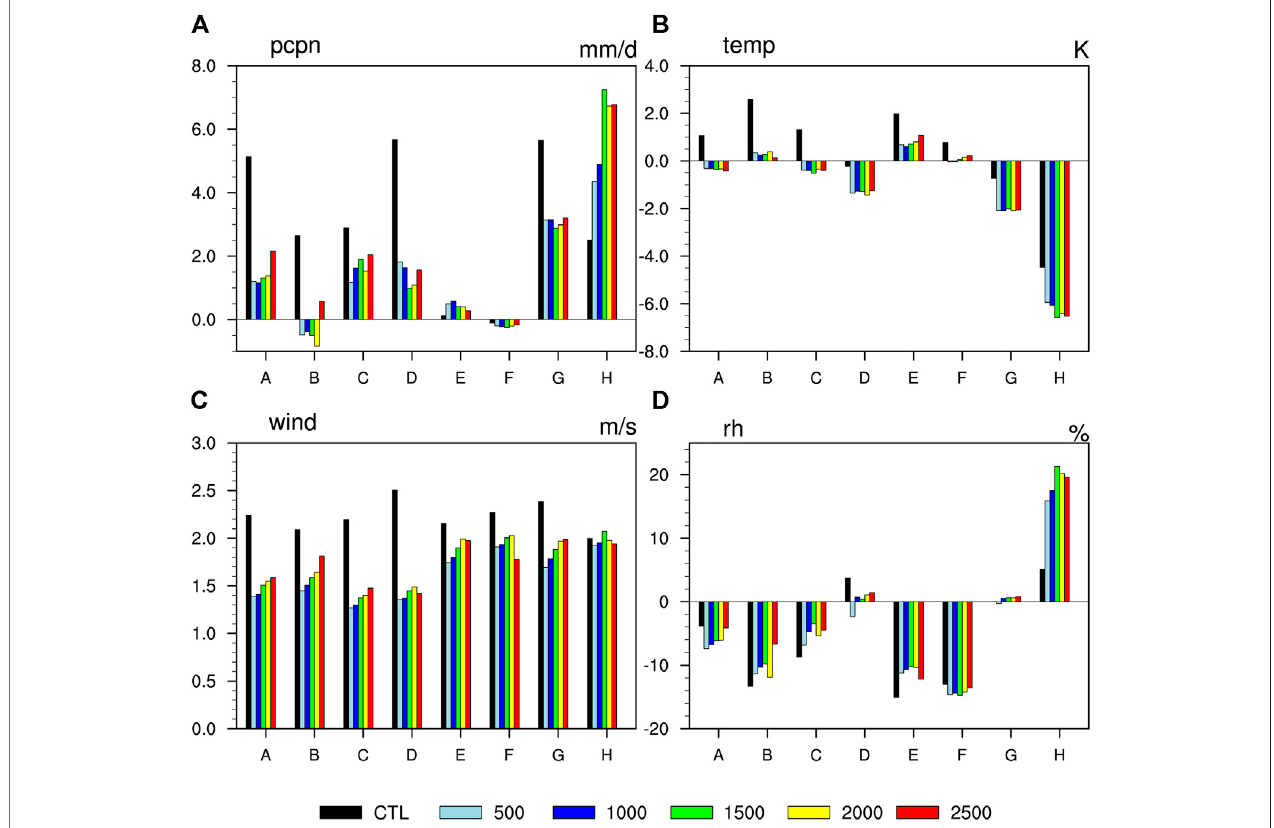
FIGURE 7 | Mean error of simulated surface meteorological fi elds with nudging all variables under different cutoff wavelengths: (A) precipitation; (B) 2 m temperature; (C) 10 m wind speed; (D) 2 m relative humidity.